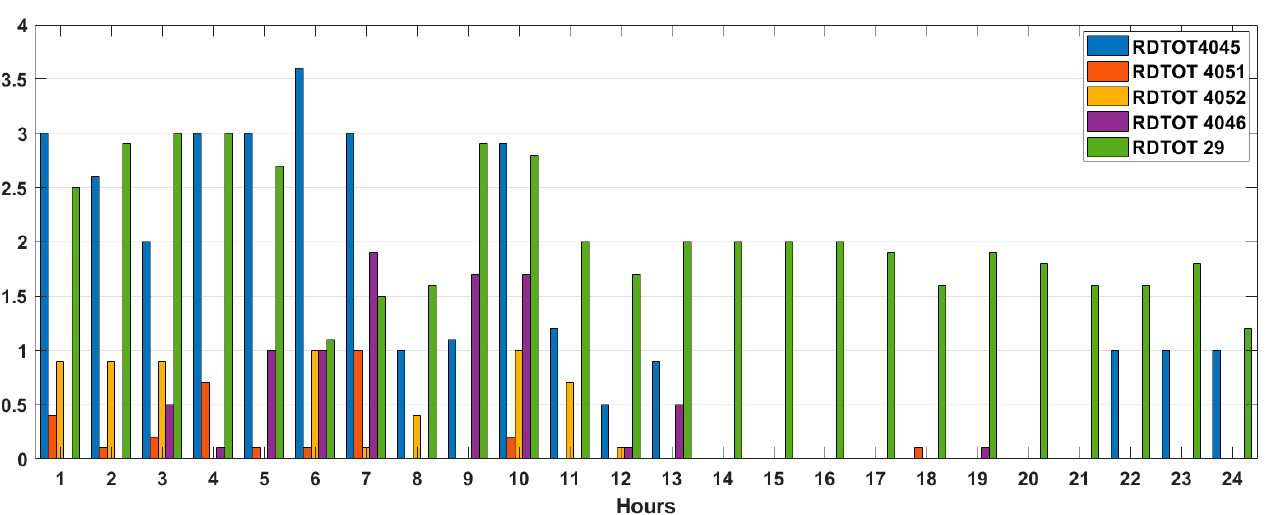
Figure 14. Chlorine injection dosage by pattern hour between the limits of 0.2 and 5 mg/L.